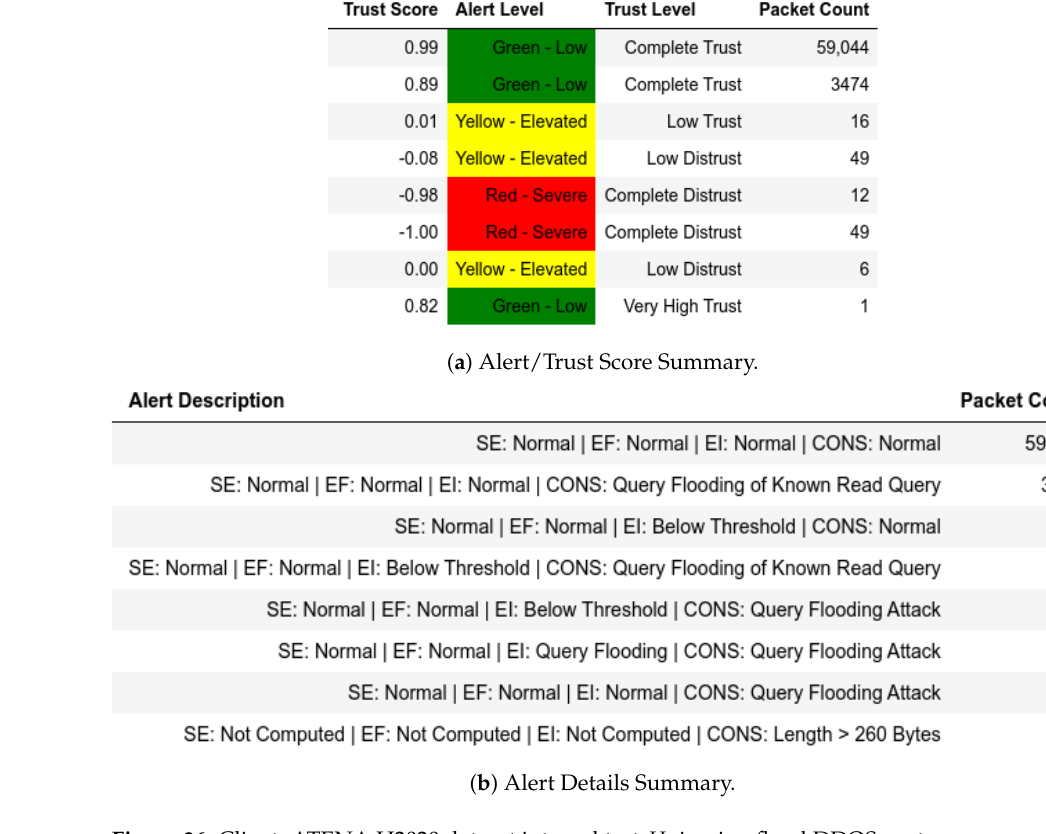
Figure 36. Client: ATENA H2020 dataset internal test- H s in ping flood DDOS